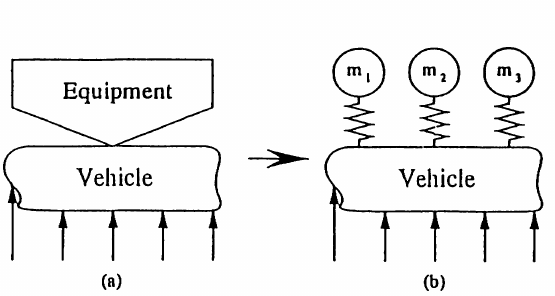
FIGURE 1 Equipment modeled by its modal oscilla tors.